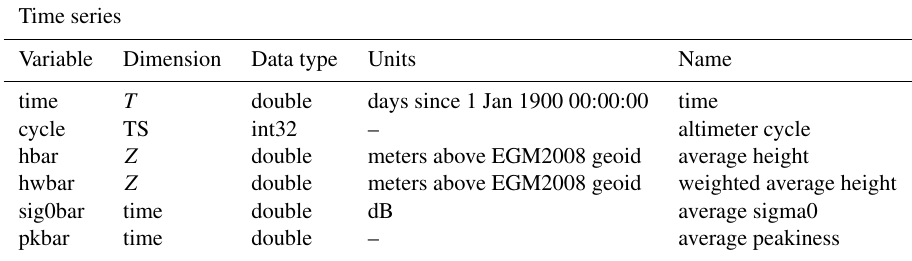
Table A3. These are pass-averaged values, having gone through the filter. There are two values that flag data: − 9999 for data that are missing from the GDR and − 9998 for data that are missing because of height/ice filters. These flags are only present when none of the values to be averaged can be found. The other values give average height (hbar), in meters, and sigma0 weighted height using.